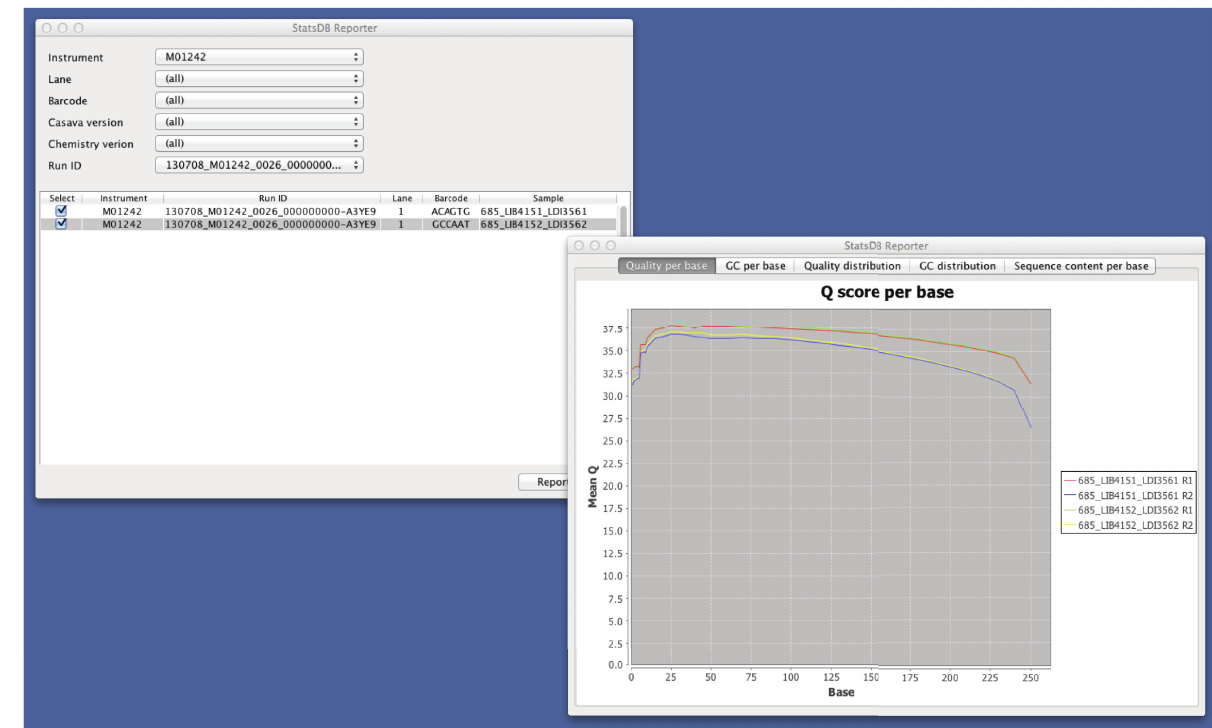
Figure 5. StatsDB Reporter allows overlay plots of QC data across instruments and